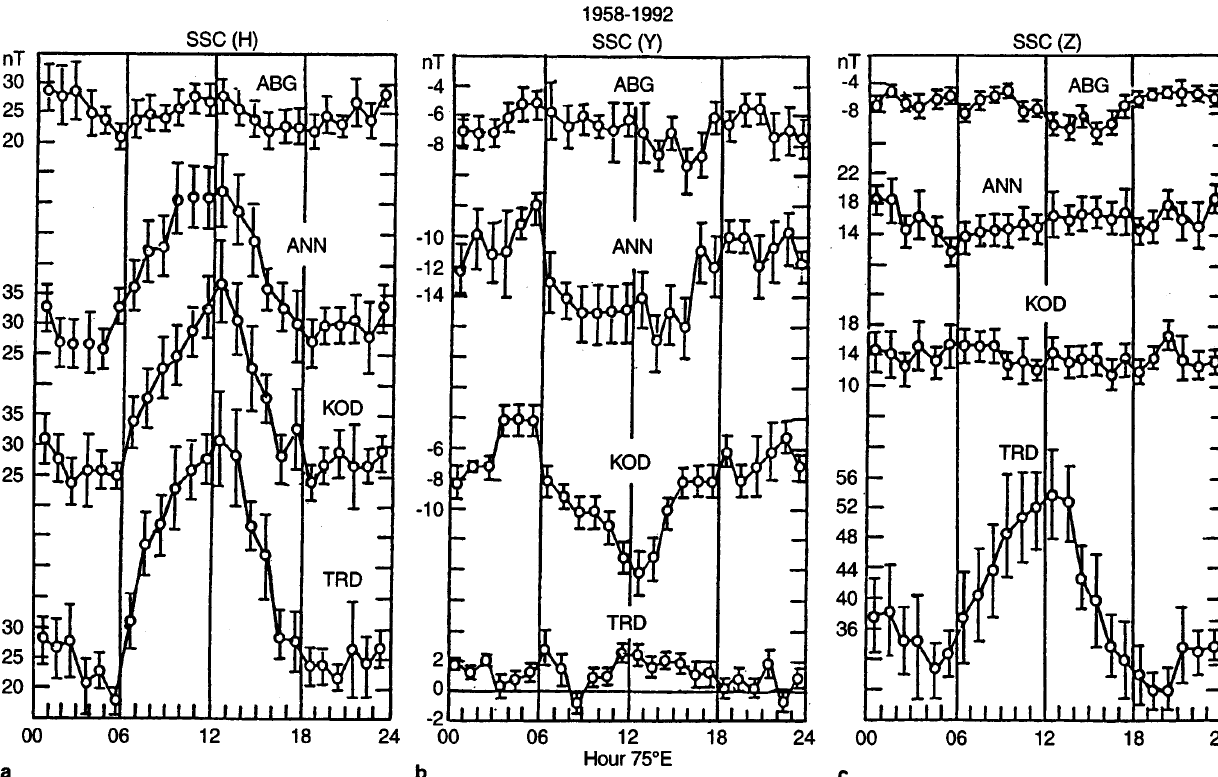
Fig. 4a–c. Solar daily variations of the amplitudes of SSC in a horizontal field, H; b eastward field, Y and c vertical field, Z averaged over 1958– 1992 at TRD , KOD , ANN and